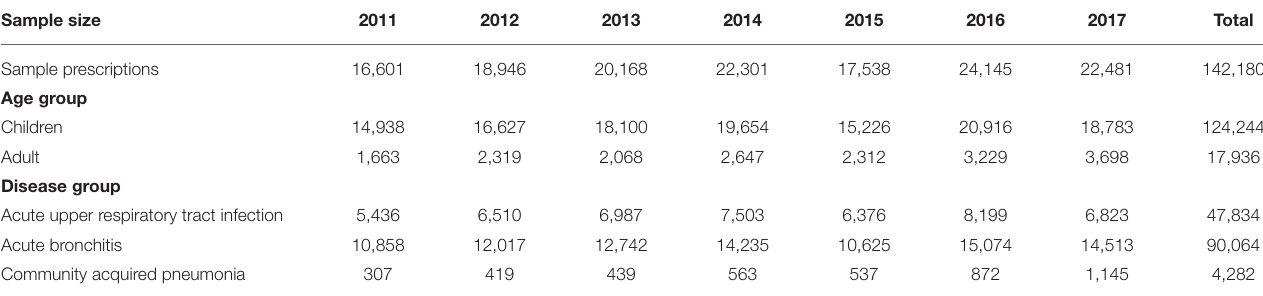
TABLE 1 | Sample size and characteristics of prescriptions in county-level hospitals in Sanming. Sample size